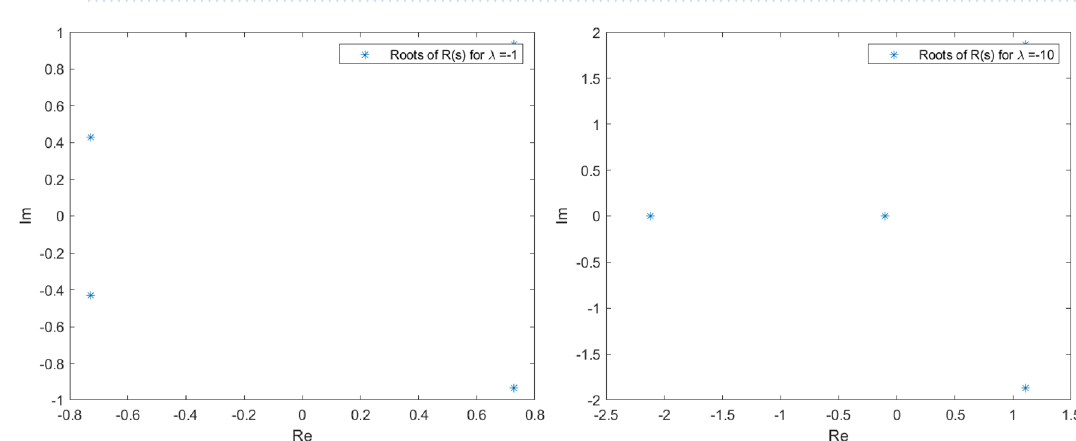
Figure 2. Complex domain (real part—horizontal axis, imaginary part—vertical axis) for (cid:31) = 100 (left) and (cid:31) = 1000 (right). Evolution of R ( s ) roots in the complex domain considering � 1 < ǫ → 0 and | y | µ that at least one root has Re ( s ) > 0 .